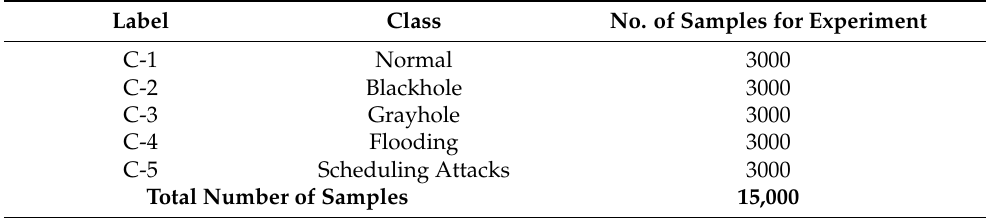
Figure 3. Confusion matrices of AOEDBC-DL system ( a ) Experiment-1, ( b ) Experiment-2, ( c ) Exper- iment-3, ( d ) Experiment-4, and ( e ) Experiment-5. The intrusion recognition results of the AOEDBC-DL model are examined in Table 2 and Figure 4. The outcomes established that the AOEDBC-DL model recognized the intru- sions proficiently. For example, in Experiment-1, the AOEDBC-DL model offered an aver- age 𝑎𝑐𝑐𝑢 𝑦 of 98.75%, 𝑠𝑒𝑛𝑠 𝑦 of 96.88%, 𝑠𝑝𝑒𝑐 𝑦 of 99.22%, 𝐹 𝑠𝑐𝑜𝑟𝑒 of 96.88%, and MCC of 96.10%. Concurrently, in Experiment-3, the AOEDBC-DL algorithm has gained an average